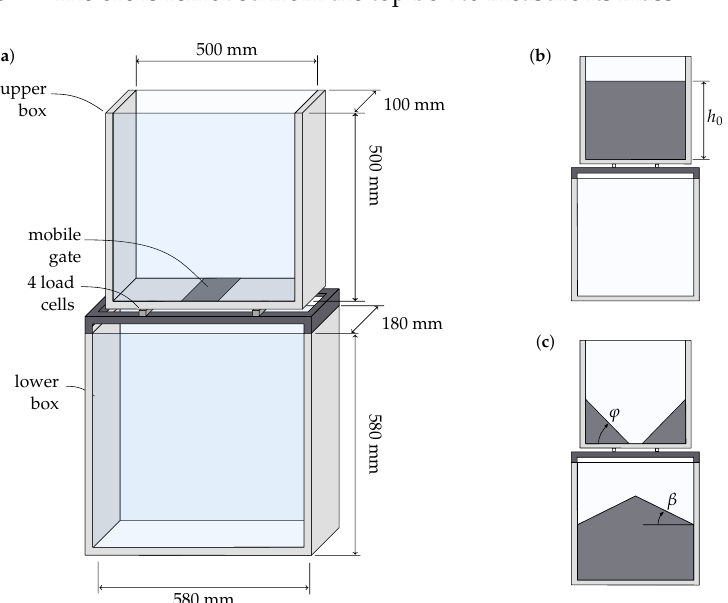
Figure 2. Draw Down Test: ( a ) Test bench schematic, presenting all the dimensions of the upper and lower box and the position of the load cells, ( b ) filling of the upper box up to height h 0 , ( c ) end of the test with the angle of repose β and shear angle ϕ